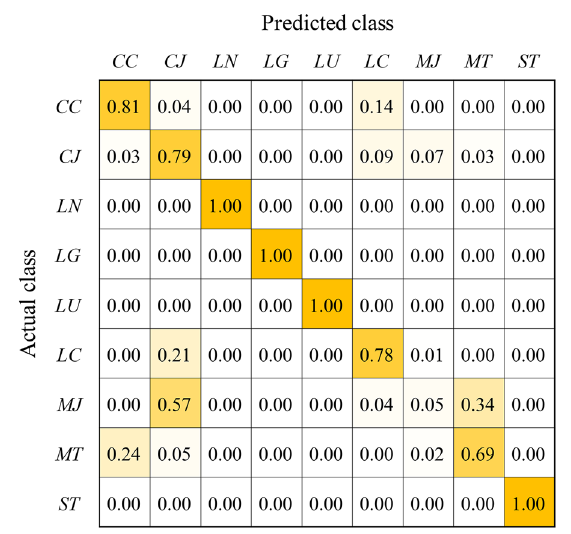
Fig. 3 Normalized confusion matrix on the test set in the recognition model. CC, Cinnamomum camphora ; CJ, Cinnamomum japonicum ; LN, Laurus nobilis ; LU, Lindera umbellata , LC, Litsea coreana ; MJ, Machilus japonica ; MT, Machilus thunbergii ; ST, Sassafras